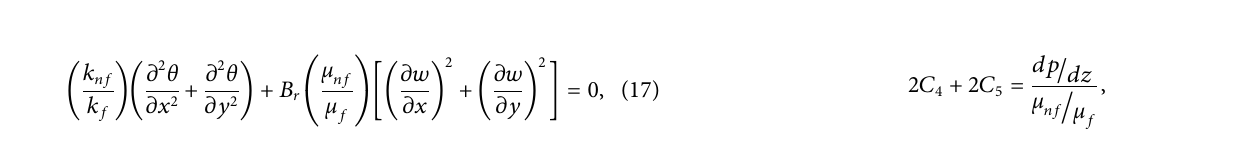
FIGURE 10 | (A) 2D-Temperature plot for ellipticalmotioneccentricity . (B) 3D-Temperature plot for ellipticalmotioneccentricity .